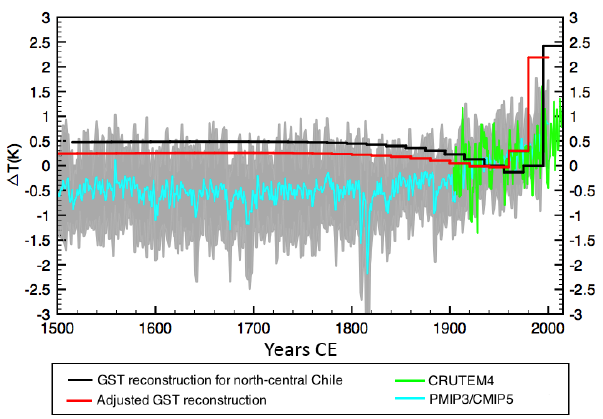
Figure 13. Comparison of two GST histories for north-central Chile (black and red lines) with the CRUTEM4 data for the north- central Chile grid point (Jones et al., 2012), and the multi-model mean surface temperature anomaly reconstruction for the PMIP3- CMIP5 (aqua) with its 2 σ standard deviation (grey shaded area). They are all presented as temperature departures from the 1920– 1940 mean. The black line is the result of the inversion of all the temperature profiles; the red line is the same adjusted to remove the effect on the inversion of a hypothesized short marked cooling ( − 2K) event between 1950 and